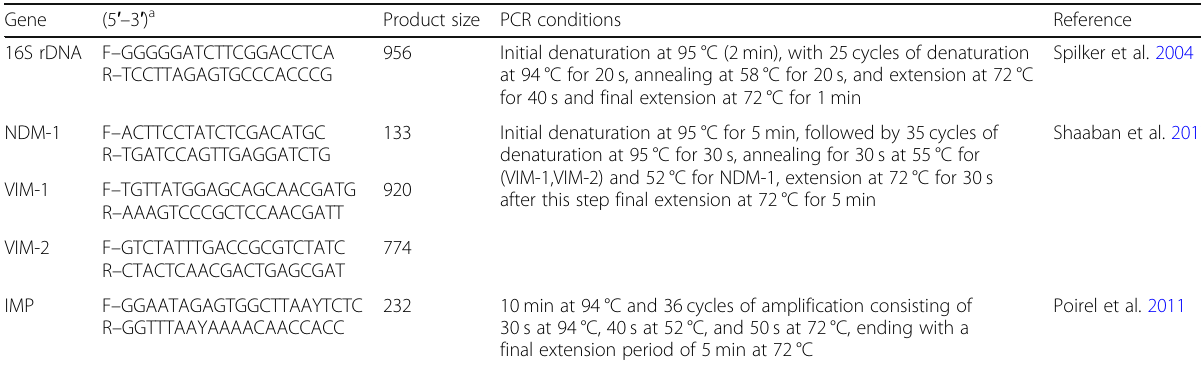
Table 1 Oligonucleotide primers used for PCR amplification